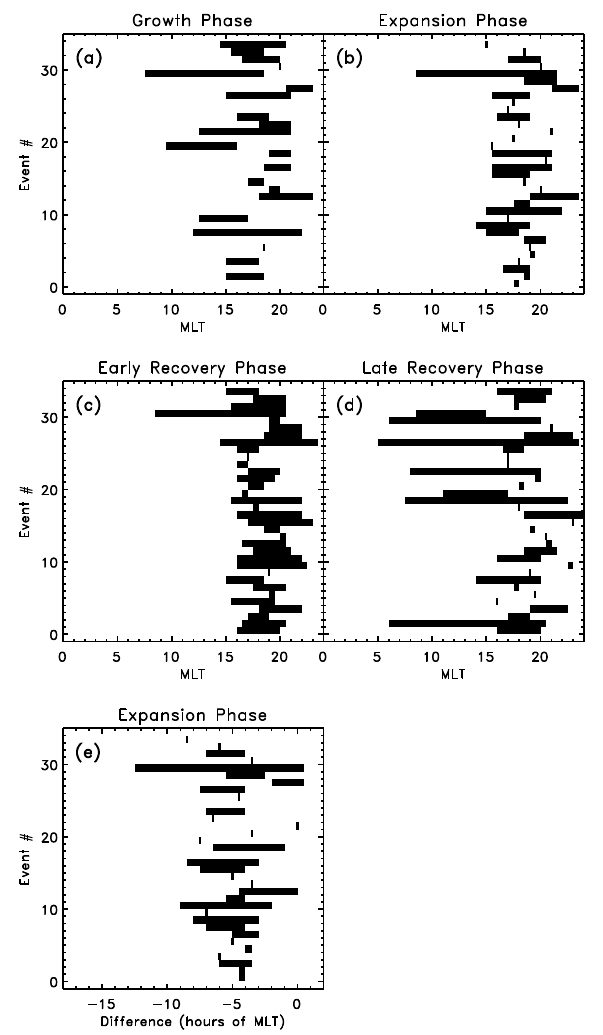
Fig. 5. Panels (a) through (e) are all related to the AU station lo- cation. Black horizontal bars indicate the MLT interval in which the AU defining station was located in the particular phase. Early and late recovery phases are defined as the first 2/3 of the recovery phase and the last 1/3, respectively. Panel (e) shows the difference between the AU station and the visible onset location (positive is toward